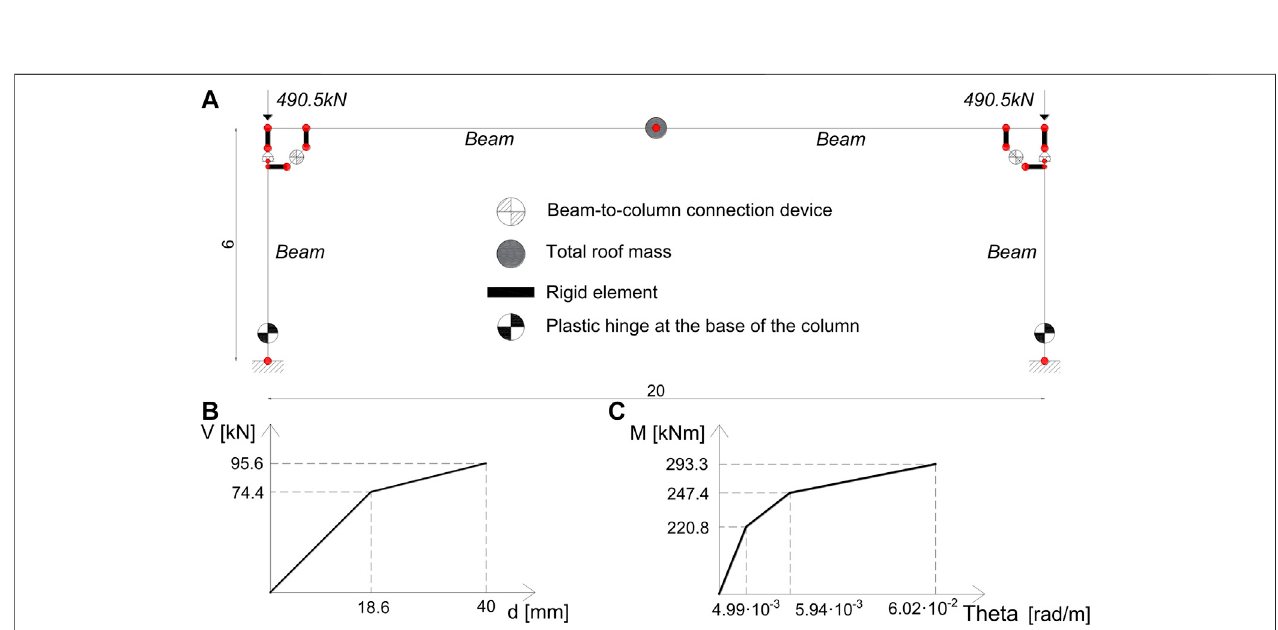
FIGURE 11 | Schematic view of the fi nite element model (A) , total force-displacement behavior of the devices (B) and moment-curvature behavior of the plastic hinge at the base of the column (C) .